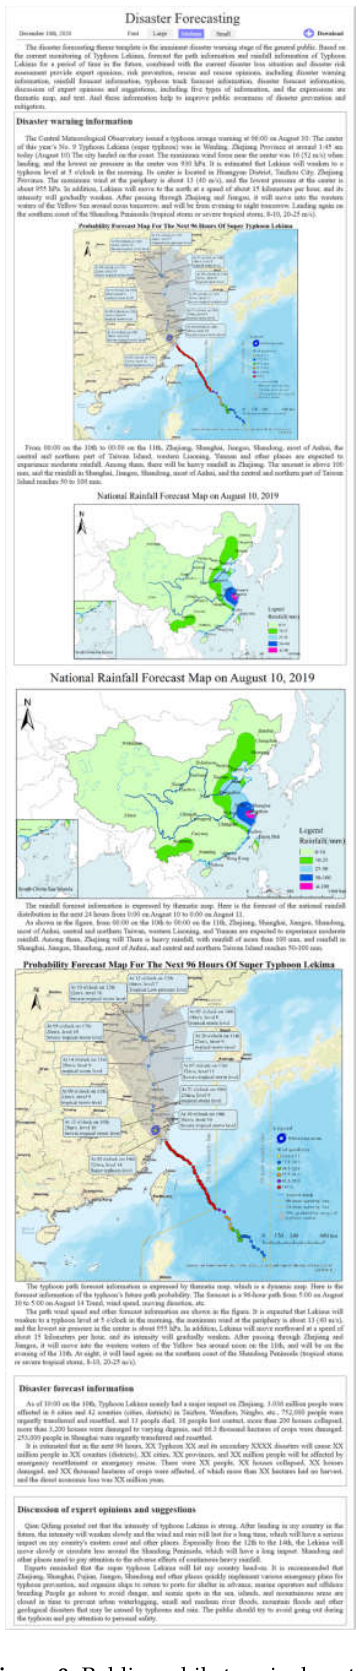
Figure 9. Public mobile terminal content display map.